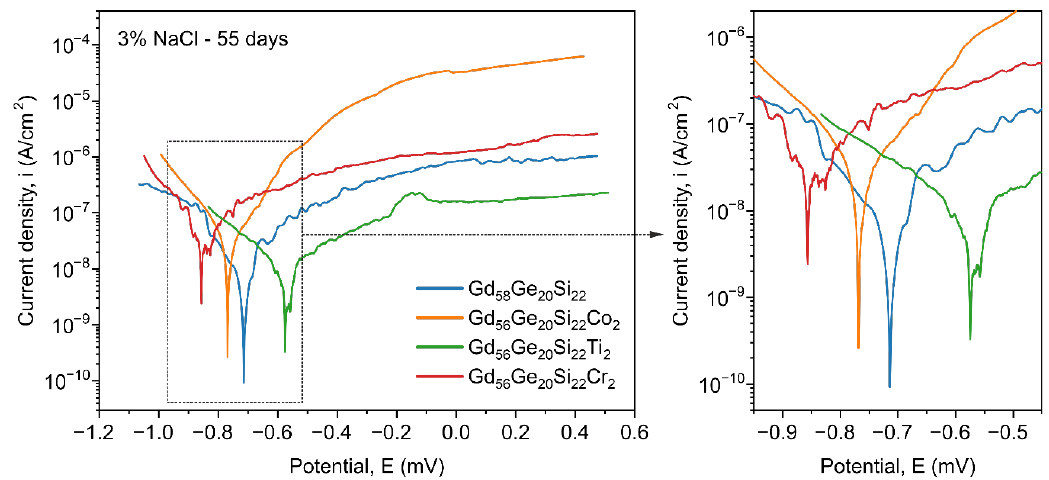
Figure 7. Polarisation curves determined in 3% NaCl solution for the the Gd 58-x Ge 20 Si 22 Y x (x = 0 or 2; Y = Co, Ti or Cr) alloys after 55 days exposure. Table 1. Corrosion potential ( E corr ), cathodic to anodic transition potential ( E C–A ), polarization resistance ( R p ) and corrosion current density ( i corr ) for the Gd 58 Ge 20 Si 22 , Gd 56 Ge 20 Si 22 Co 2 , Gd 56 Ge 20 Si 22 Ti 2 and Gd 56 Ge 20 Si 22 Cr 2 alloys in 3% NaCl solutions after two exposure